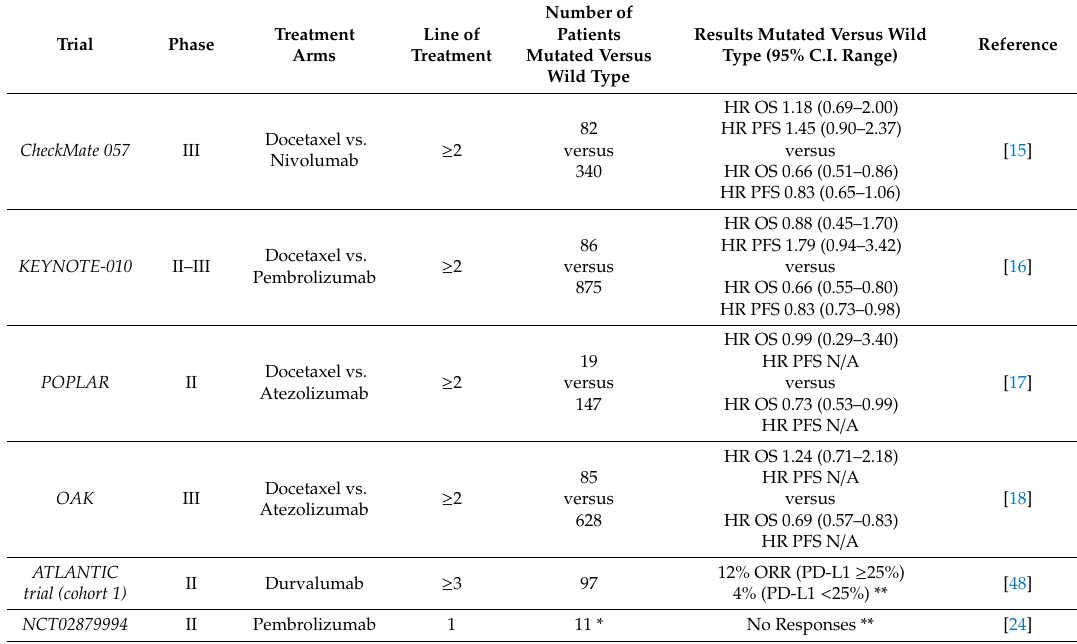
Table 1. Studies of ICIs where patients with EGFR mutation were